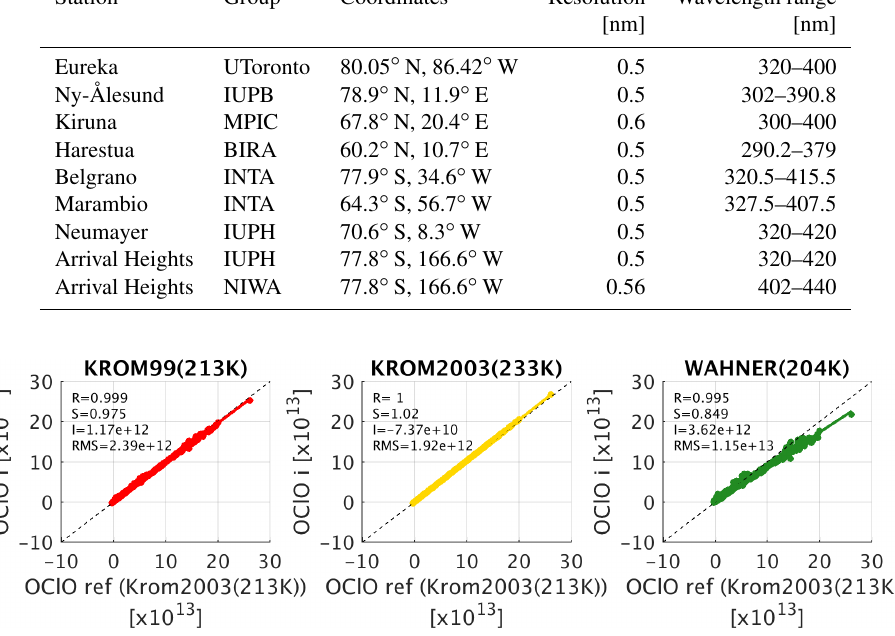
Figure A1. Regression analysis of OClO SCDs retrieved from a common set of Ny-Ålesund spectra to investigate the sensitivity of OClO results for the cross sections used. The different DOAS analyses used correspond to what is described in Table A2, for test set (1) with respect to OClO values obtained using the Kromminga et al. (2003) cross section at 213K as in